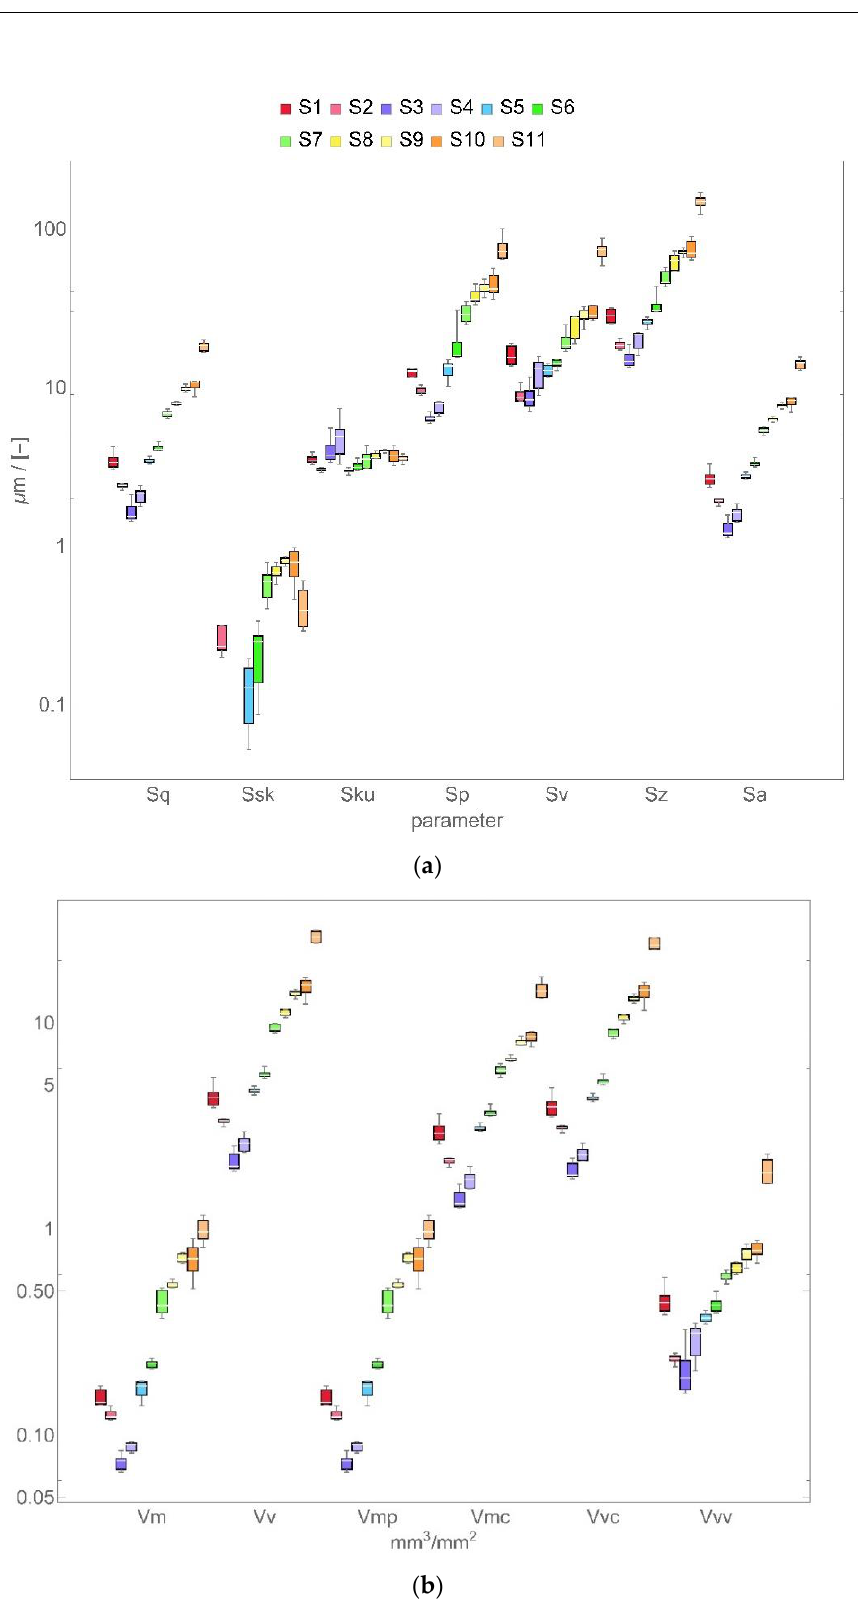
Figure 3. Conventional areal characterization parameters plotted as a function of surface number: ( a ) height, ( b ) volume parameters. Please note that each box size indicates 25th and 75th percentiles, the white bar represents median and whiskers shows maximum and minimum values calculated for each scale.